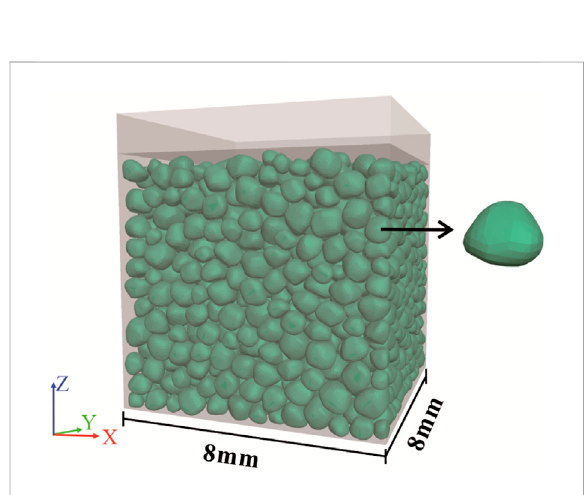
FIGURE 11 Simulation device and sample for mechanical compaction simulation.